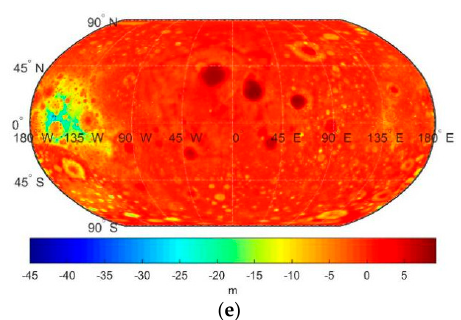
Figure 3. The geoid-to-quasigeoid separation on ( a ) Mercury, ( b ) Venus, ( c ) Earth, ( d ) Mars and ( e ) the Moon.